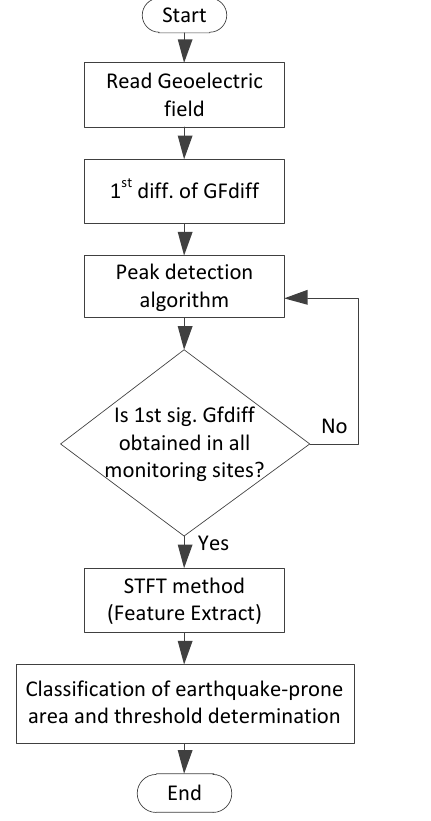
Fig. 2. Flowchart of the proposed feature extraction technique. Fig.2. Flowchart of the proposed feature extraction technique.